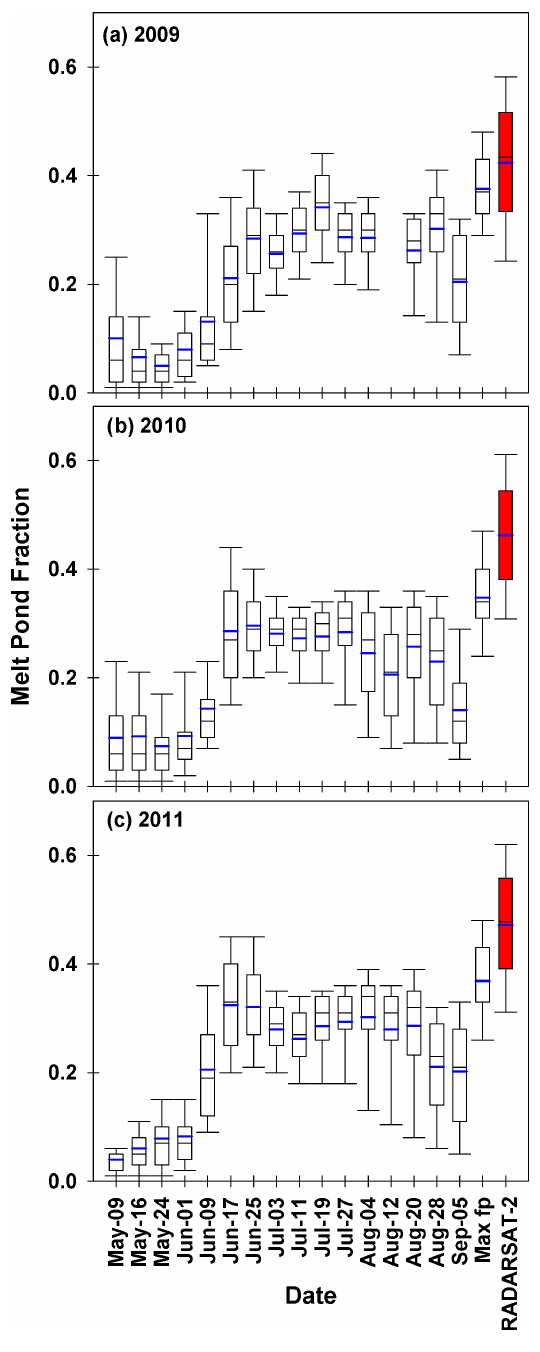
Figure 8. Boxplots of the seasonal time series of MODIS melt pond fraction ( f p ), the maximum seasonal MODIS f p and RADARSAT- 2 peak melt pond fraction ( f pk ) for (a) 2009, (b) 2010 and (c) 2011. The solid blue line represents the